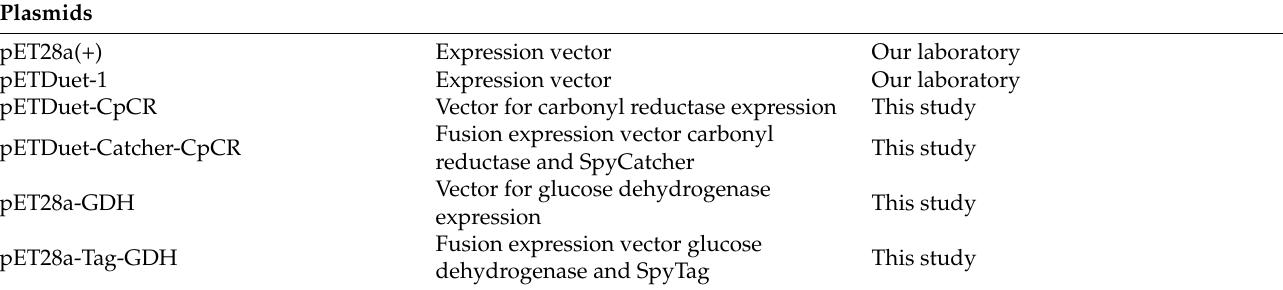
Table 3. Plasmids constructed in this